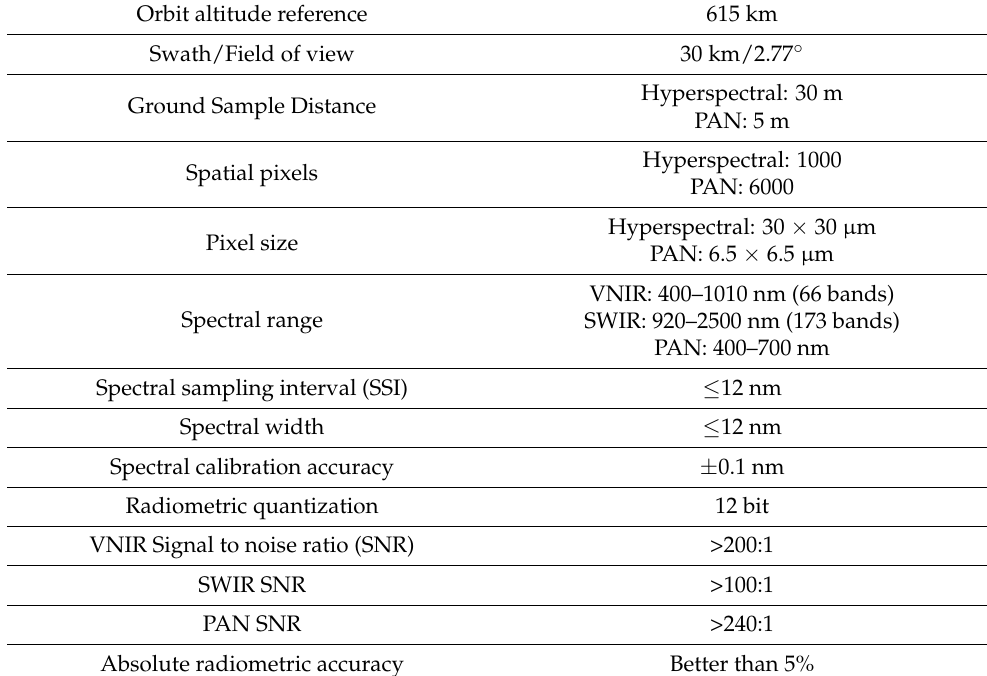
Table 2. Main characteristics of PRISMA mission